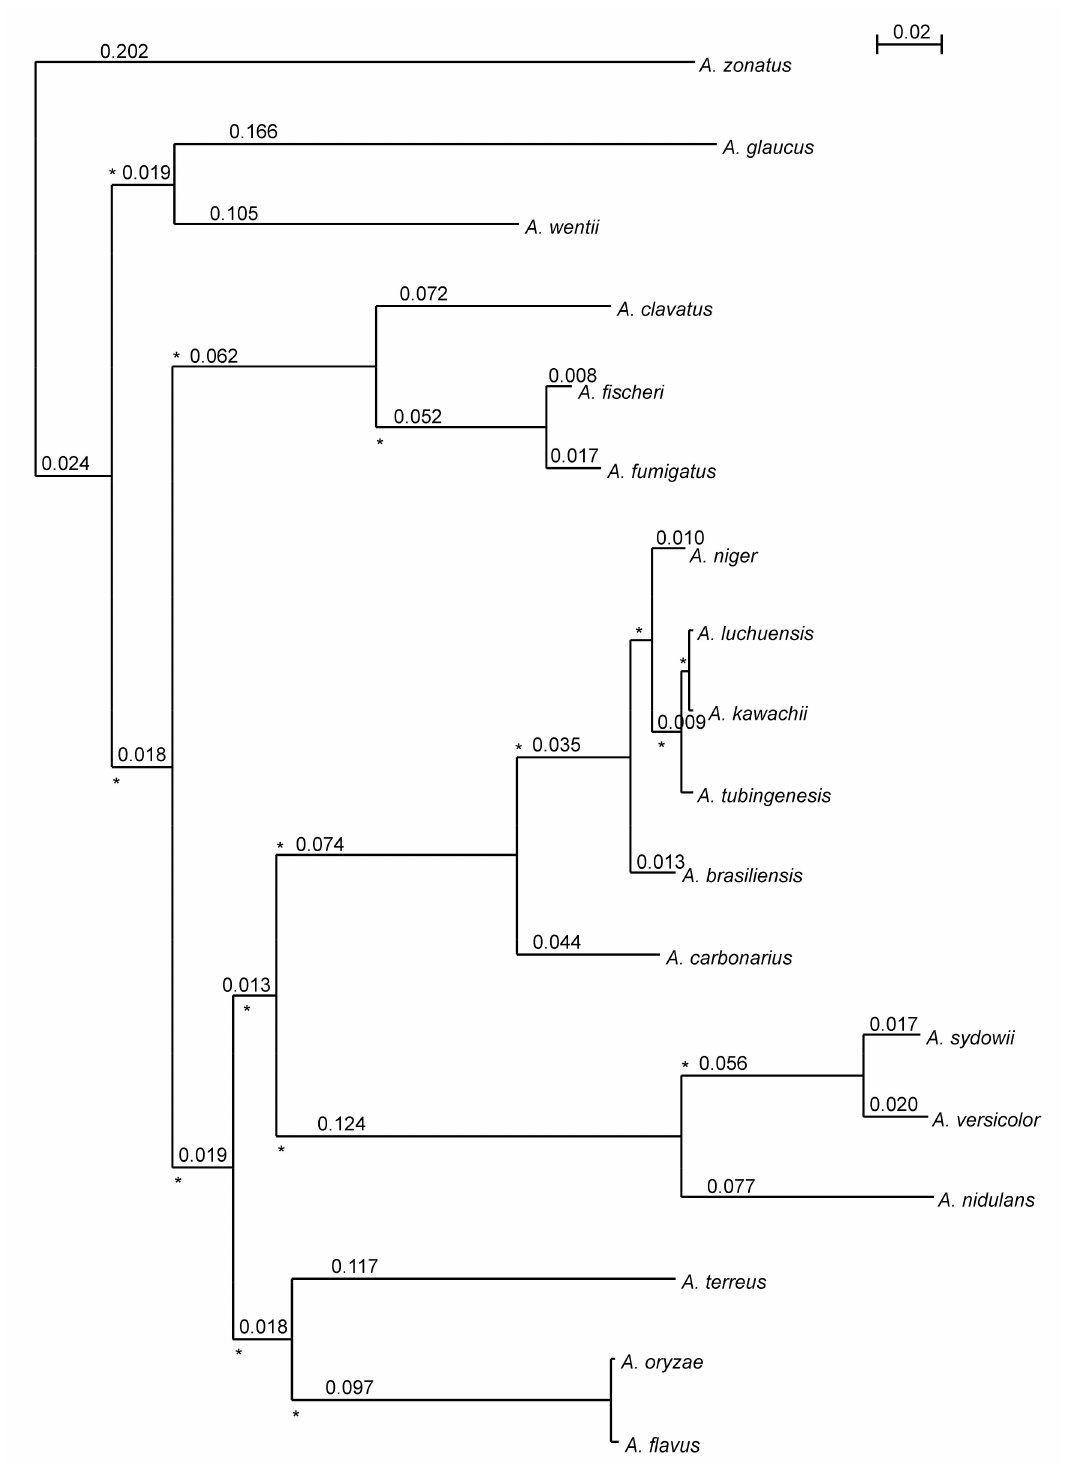
Figure 3. Aspergillus species tree. The maximum likelihood tree was obtained after concatenating the 3175 congruent orthologous proteins or protein fragments shared by all 18 genomes. On the branches of the tree are reported the branch length (black). The branches of the tree with 100% bootstrap support are shown by asterisks. The scale bar (s/s) indicates the number of substitutions per